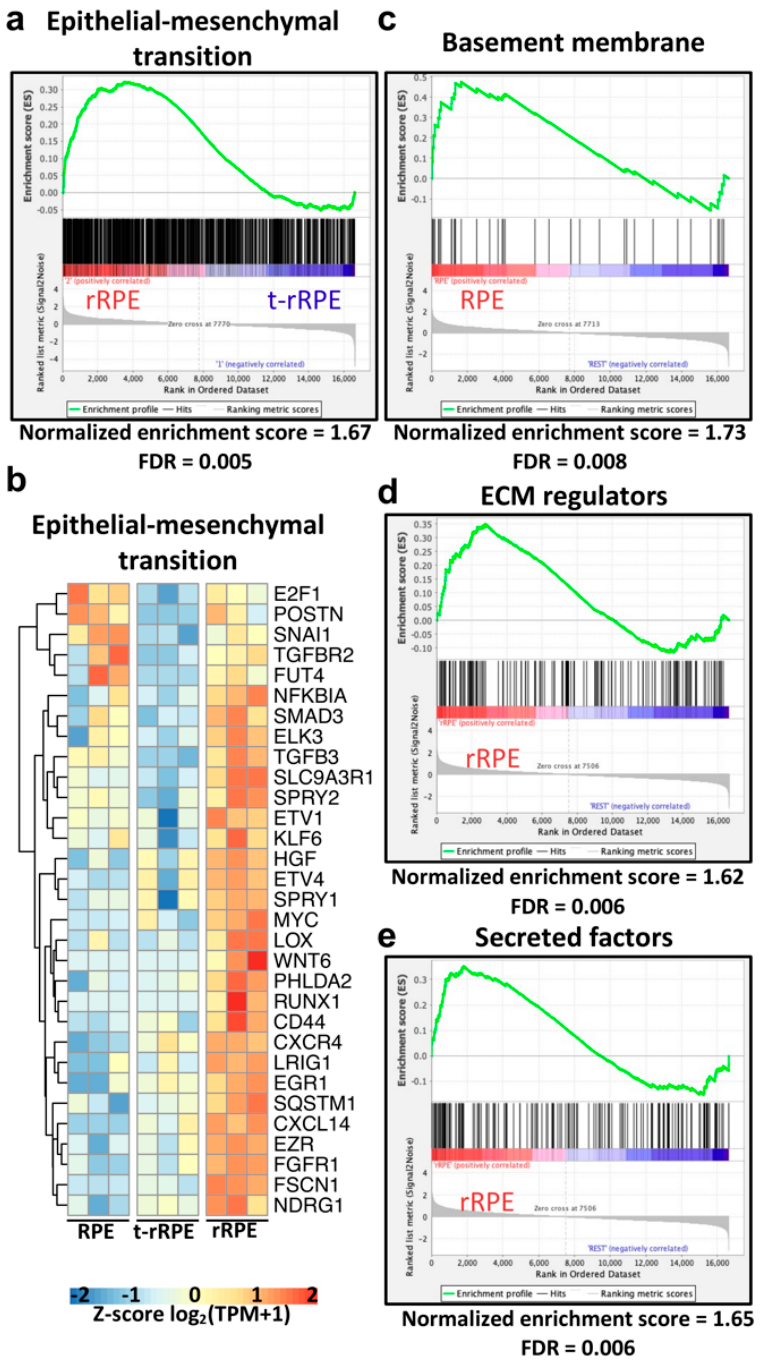
Figure 5. Epithelial-mesenchymal transition genes are highly enriched in the rRPE transcriptome, and extracellular matrix remodeling emerges as a defining feature of reprogramming. ( a ) Gene set enrichment analysis (GSEA) was conducted using the dbEMT 2.0 database and revealed signifi- cant enrichment (false discovery rate [FDR] = 0.005) of EMT-associated genes in the rRPE relative